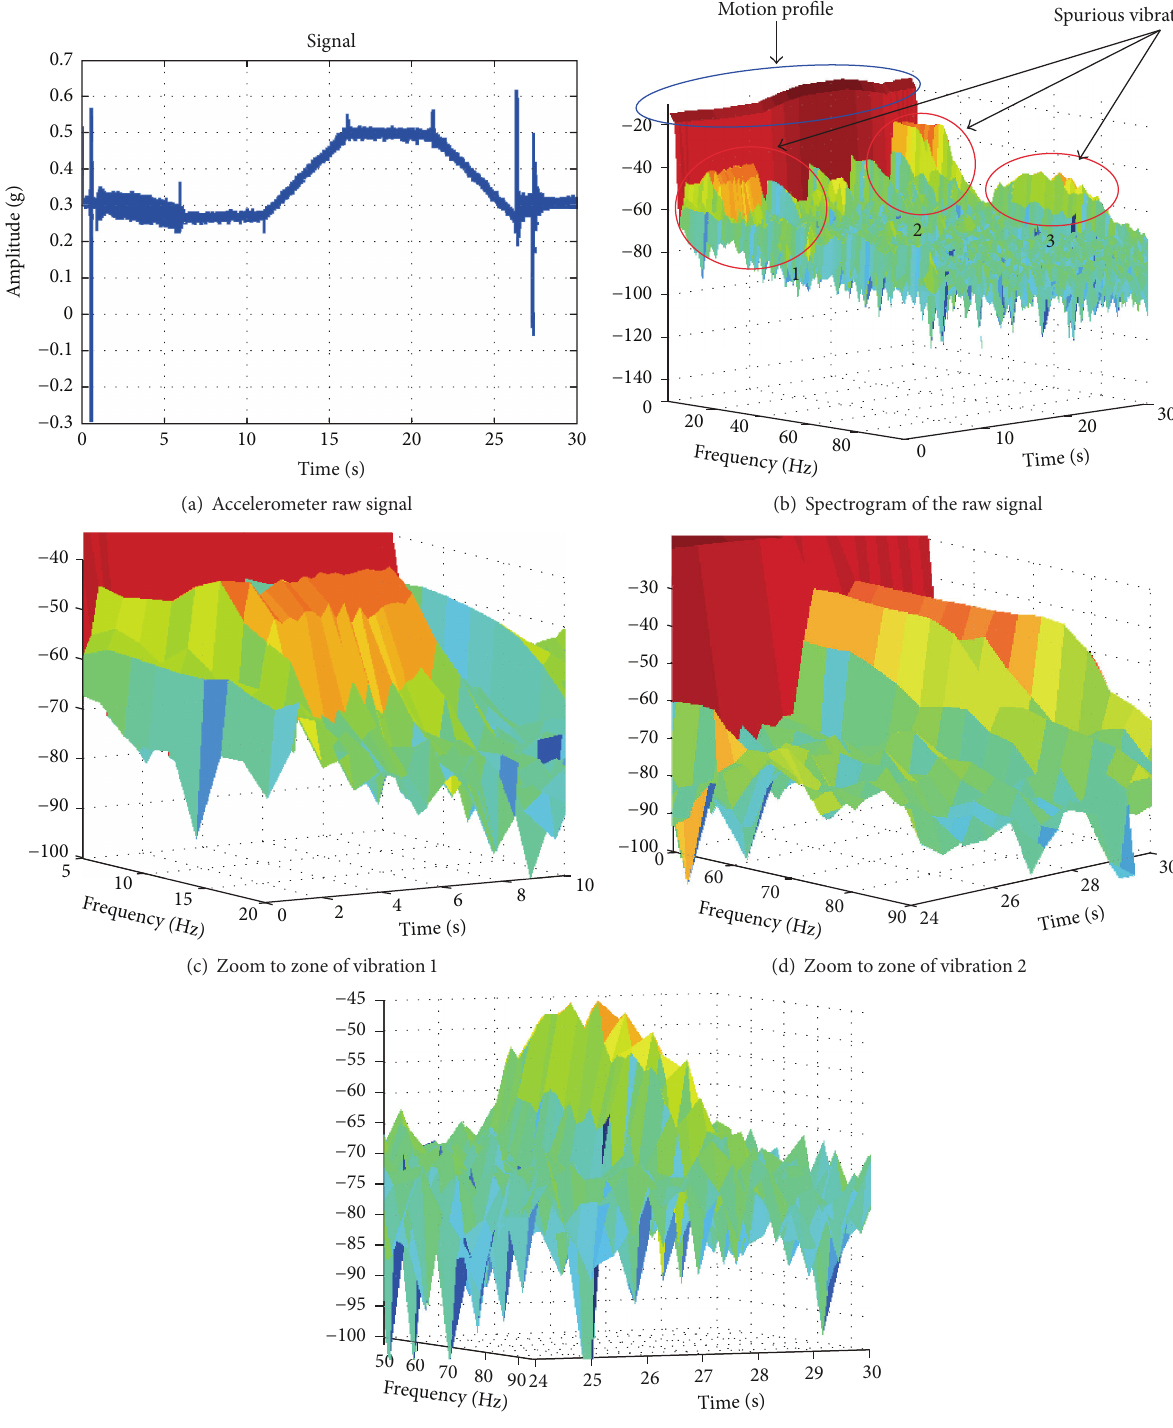
Figure 7: One axis motion profile with noise due to